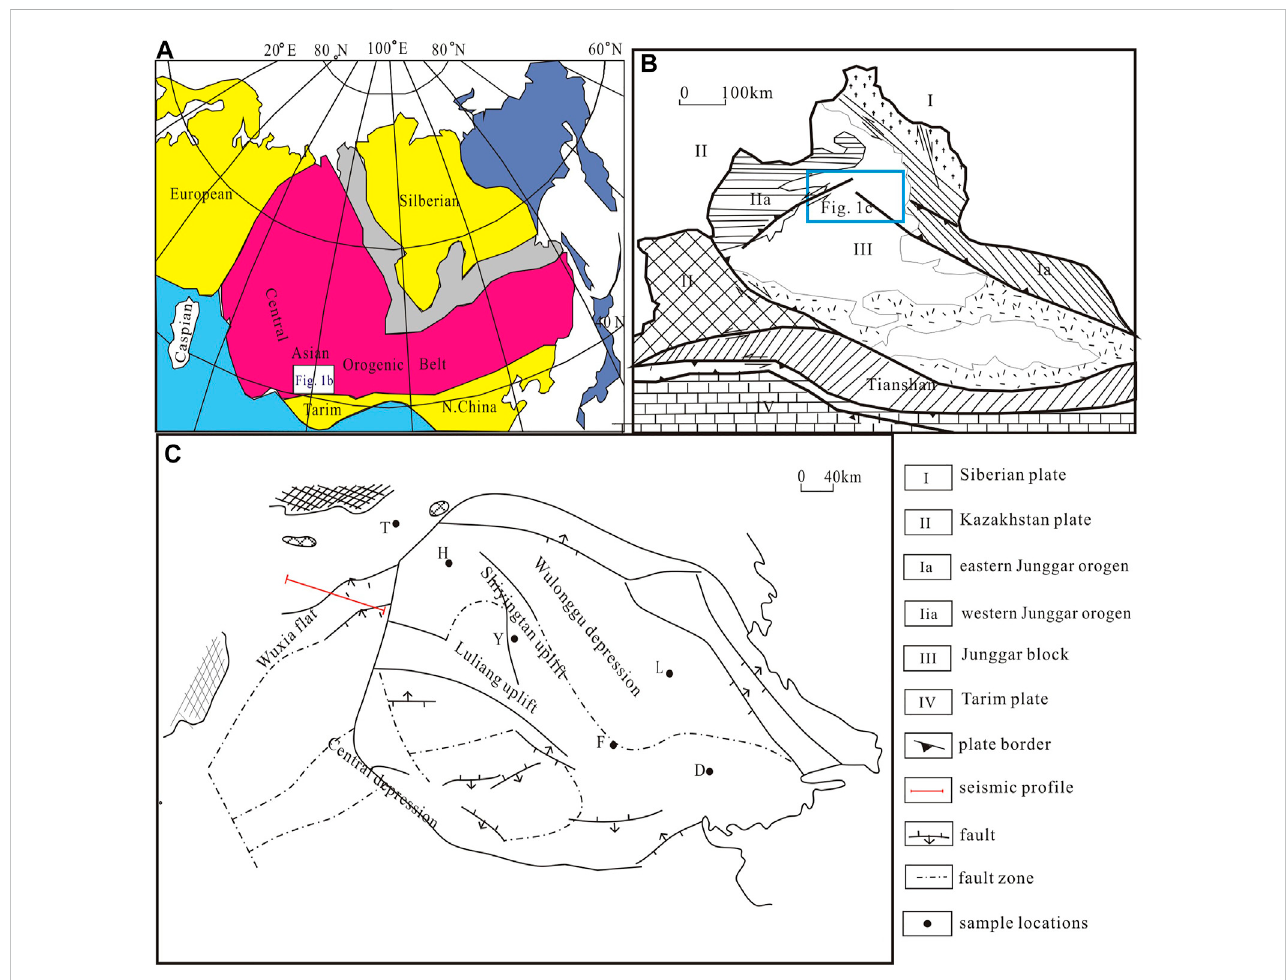
FIGURE 1 (A) Simpli fi ed tectonic map of the Central Asian Orogenic Belt. (B) Structural map of Junggar Basin and its adjacent areas (modi fi ed from Li et al., 2010). (C) Structural sketch and sample collection points of the study